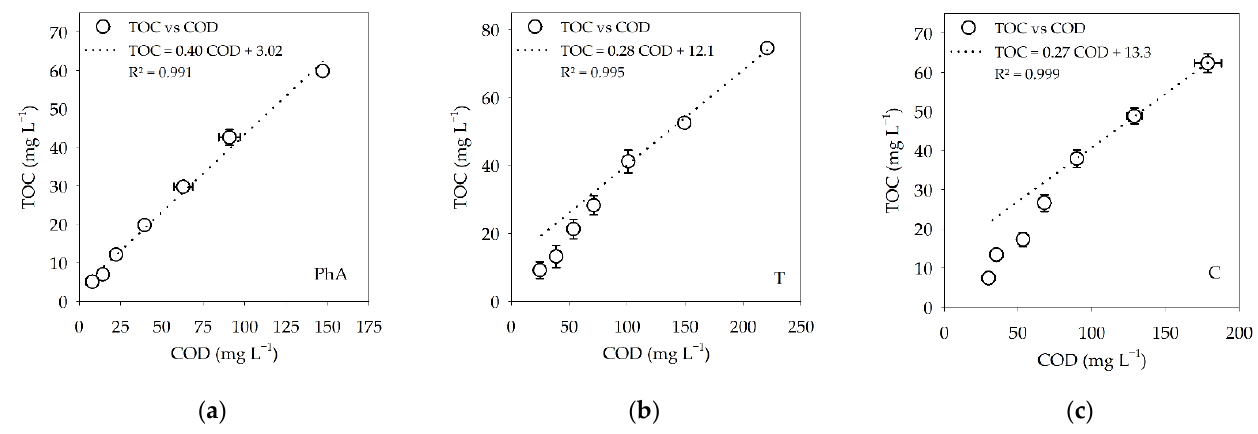
Figure 2. TOC vs. COD plots for EO assays performed with ( a ) PhA, ( b ) T, and ( c ) C in the presence of inorganic ions. Table 2. Results from application of Equations (2) and (3) to experimental data obtained in EO assays performed with solutions PhA_1, T_1, and C_1.